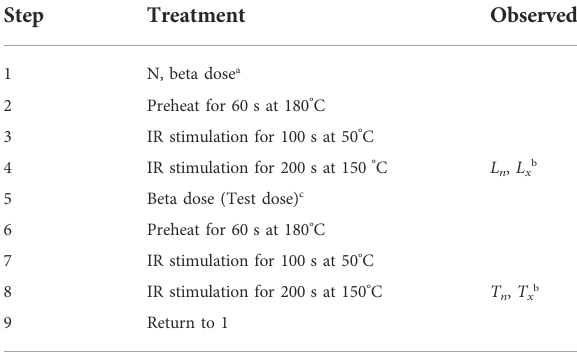
TABLE 2 The protocol of K-feldspar pIRIR 150 dating.